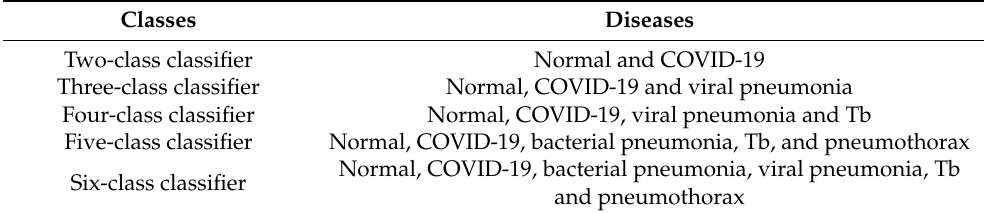
Table 3. Assignment of diseases according to different classifiers.